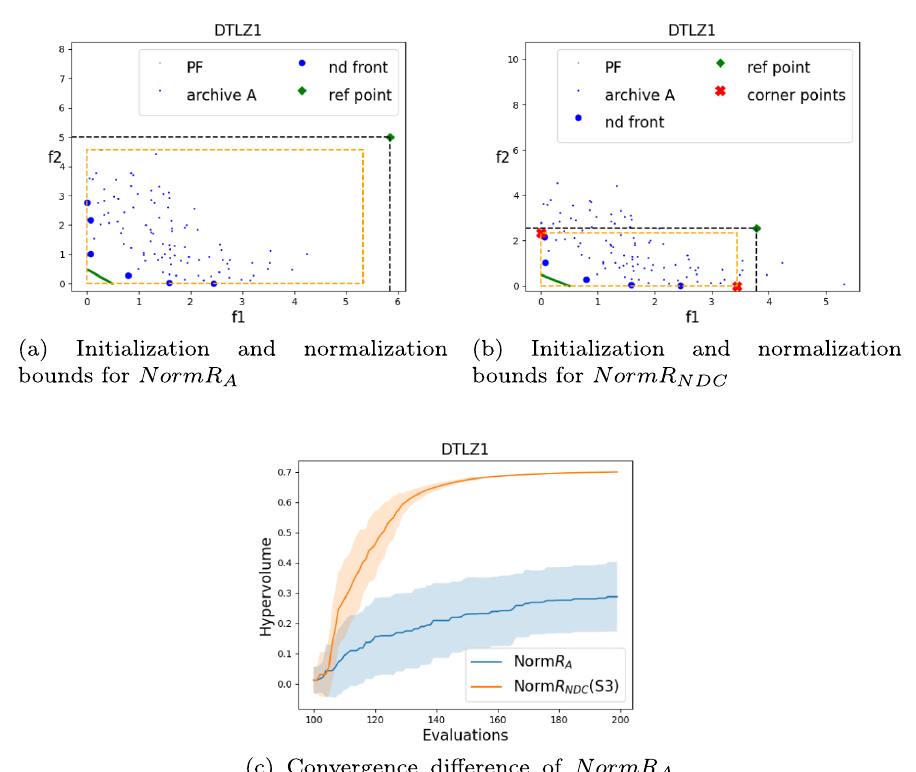
Fig. 6 DTLZ1 example of search behavior